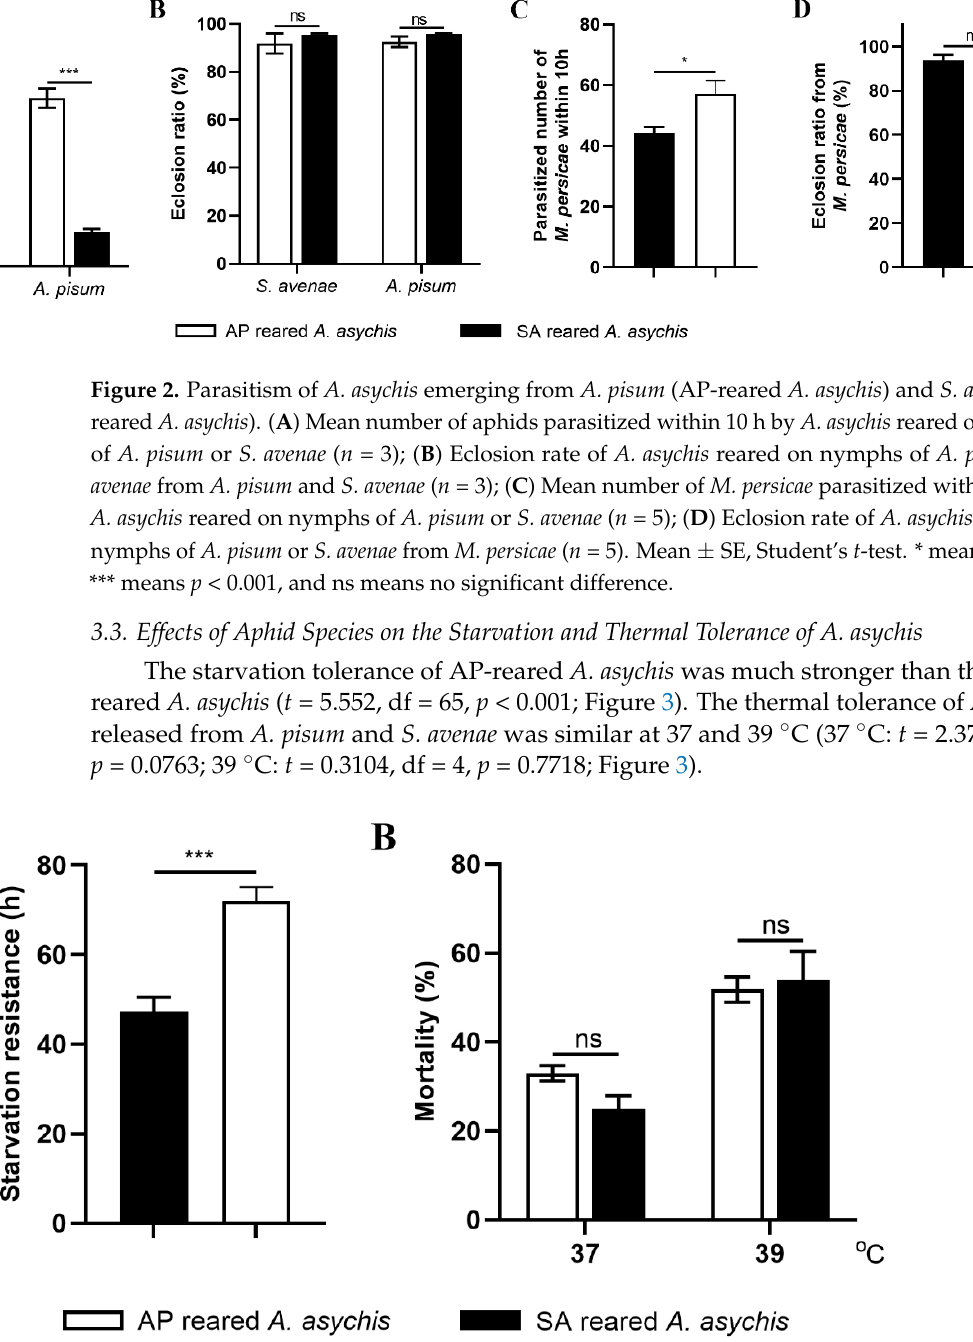
Figure 3. Starvation ( A ) and thermal tolerance ( B ) of A. asychis reared on nymphs of A. pisum (AP-reared A. asychis ) or S. avenae (SA-reared A. asychis ). Mean ± SE, Student’s t -test. Starvation: n ≥ 30; thermal tolerance: n = 3 (per replicates 30 female adults). *** means p < 0.001, and ns means no significant difference.